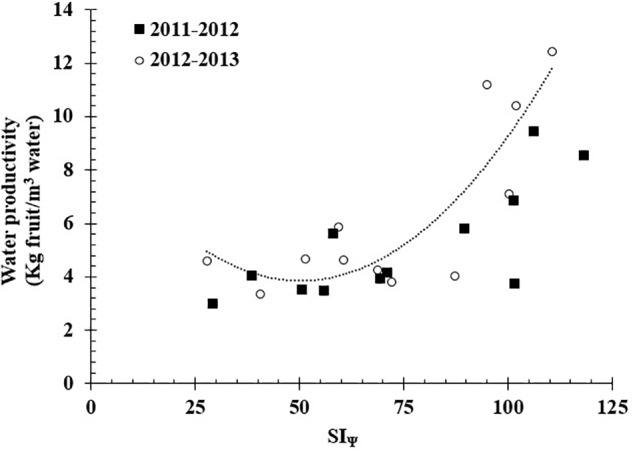
Relationship between integral water stress (SIΨ) and water productivity (WP = 0.0022SIΨ2–0.2206SIΨ+9.396; R2 = 0.74) in a grafted Carménère vineyard during the 2011/12 and 2012/13 growing season.